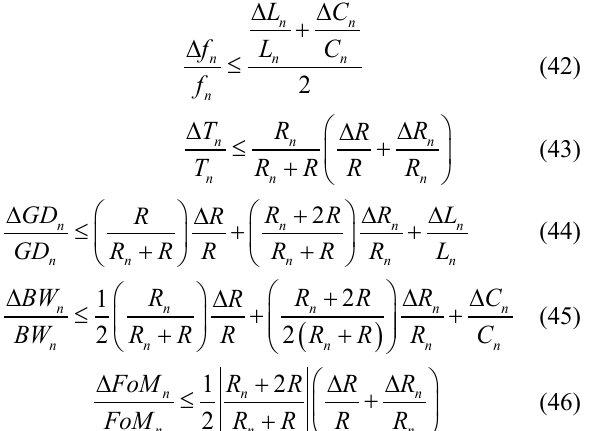
FIGURE 9. Variations of the VTF magnitude, phase and GD with respect to resistance R n variation in the range from 1 m Ω to 1 k Ω